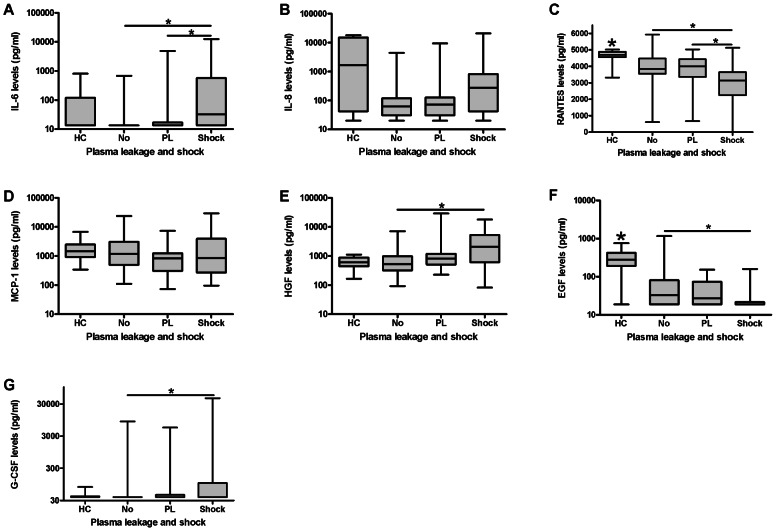
Cytokine levels in dengue virus infected patients classified according to the occurrence of plasma leakage/shock.A: IL-6: Levels in shock patients are significantly increased compared to patients with (P = 0,001) and without (P<0,0001) plasma leakage (KW P<0,0001, KW dengue groups P<0,0001). B: IL-8: No significant differences (KW P = 0,01, KW dengue groups P = 0,04). C: RANTES: Levels in shock patients are significantly decreased compared to patients with (P = 0,002) and without (P<0,0001) plasma leakage. Levels in all patient groups are significantly decreased compared to HC (No, PL and shock vs HC P<0,0001, KW P<0,0001, KW dengue groups P = 0,001). D: MCP-1: No significant differences (KW P = 0,162, KW dengue groups P = 0,17). E: HGF: Levels in patients with shock are significantly increased compared to patients with no plasma leakage (P = 0,001) (KW P = 0,001, KW dengue groups P = 0,001). F: EGF: Levels in shock patients are significantly decreased compared to patients without (P = 0,004) plasma leakage. Levels in all patient groups are significantly decreased compared to HC (No, PL and shock vs HC P<0,0001, KW P<0,0001, KW dengue groups P = 0,015). G: G-CSF: Levels in patients with shock are significantly elevated compared to patients without plasma leakage (P = 0,002, KW P = 0,01, KW dengue groups P = 0,004). Abbreviations: HC =  healthy control, No =  no occurrence of plasma leakage, PL = plasma leakage, KW = kruskal wallis. Horizontal bars inside the boxplot indicate the median. The box indicates the interquartile range. Black asterisk = significantly different from all other groups. Underlined black asterisk = significant difference between two groups. The Mann-Whitney U test was used to compare the groups with each other.